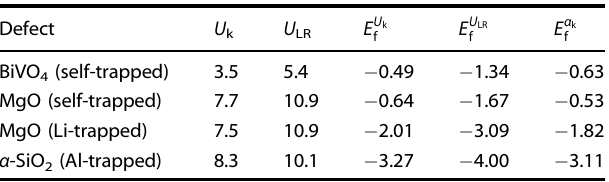
Table 3. Comparison between different schemes for the determination of U